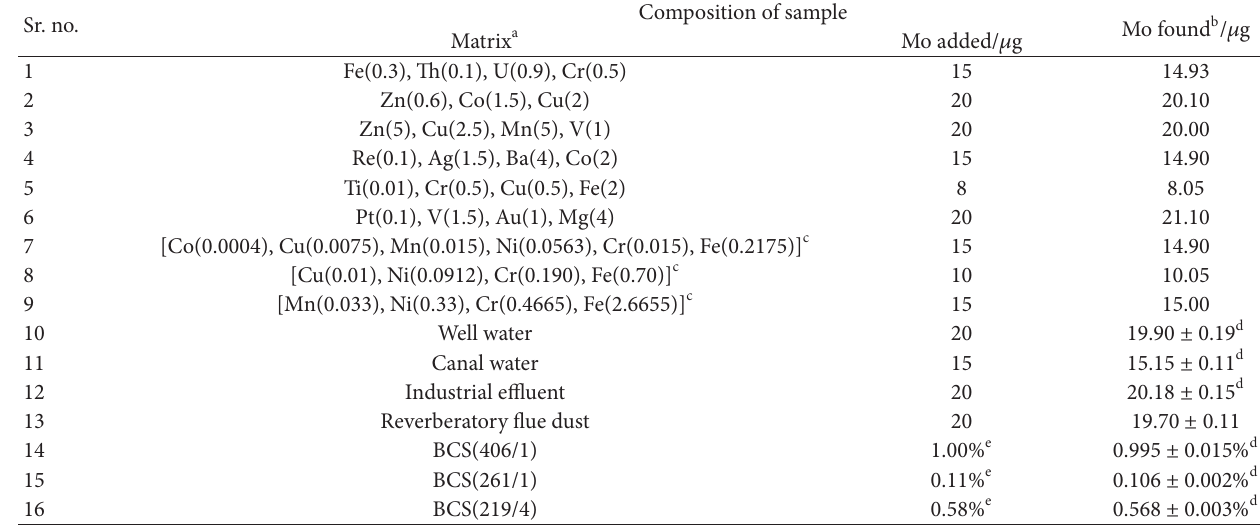
T 3: Analysis of molybdenum samples by the proposed method. Sr.